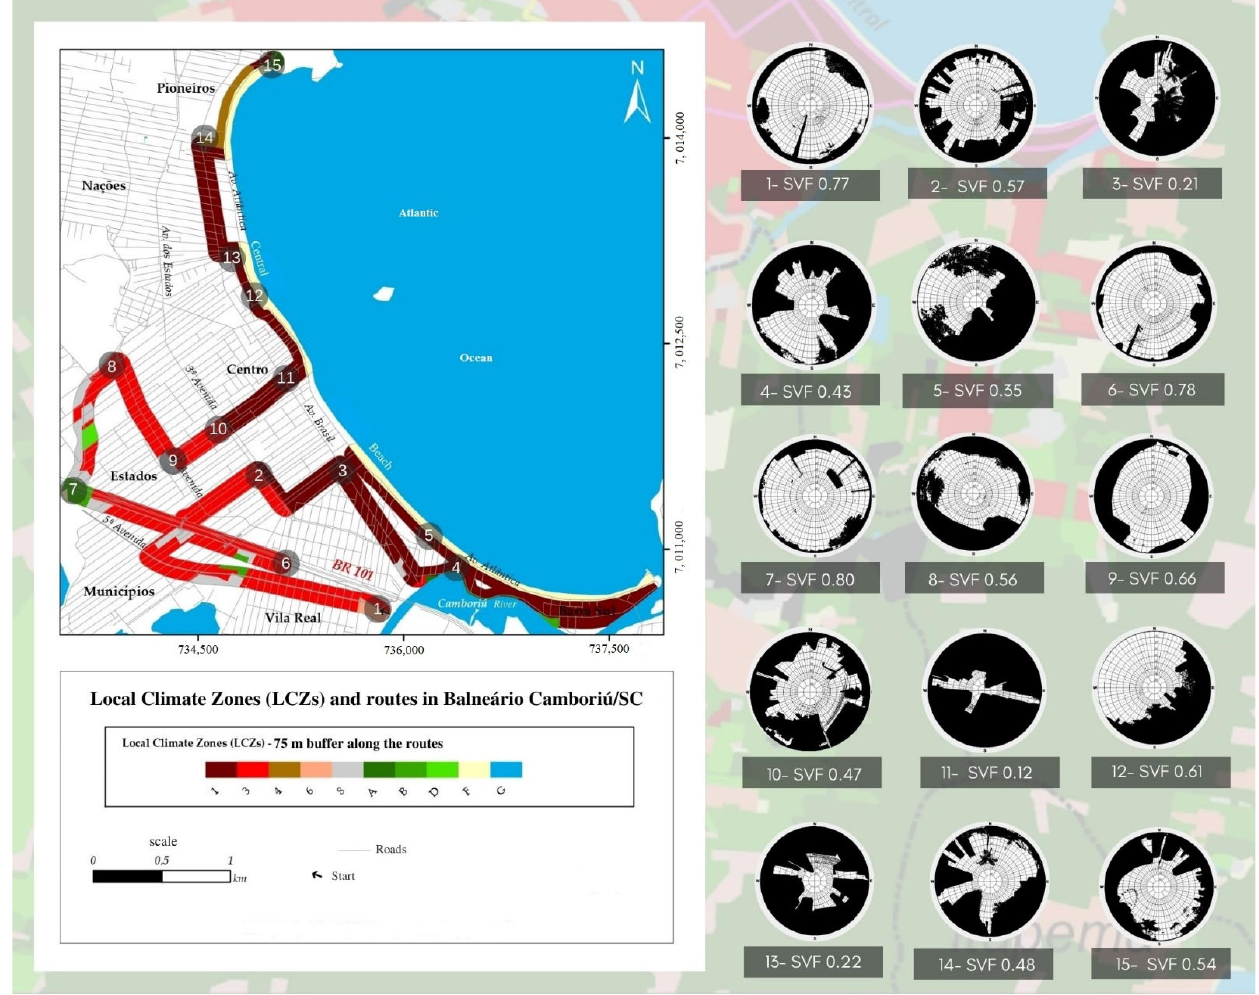
Figure 7. LCZs and SVFs available through transects. Source: Authors (2022).